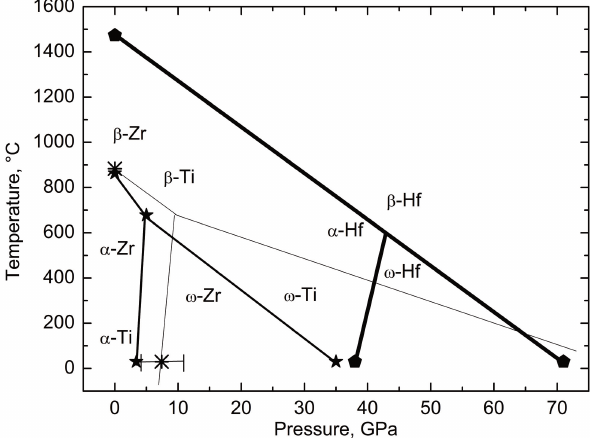
Figure 7. “Temperature – pressure” equilibrium phase di- agram for titanium (crosses, thin lines), zirconium (stars, middle-thick lines) and hafnium (pentagons, thick